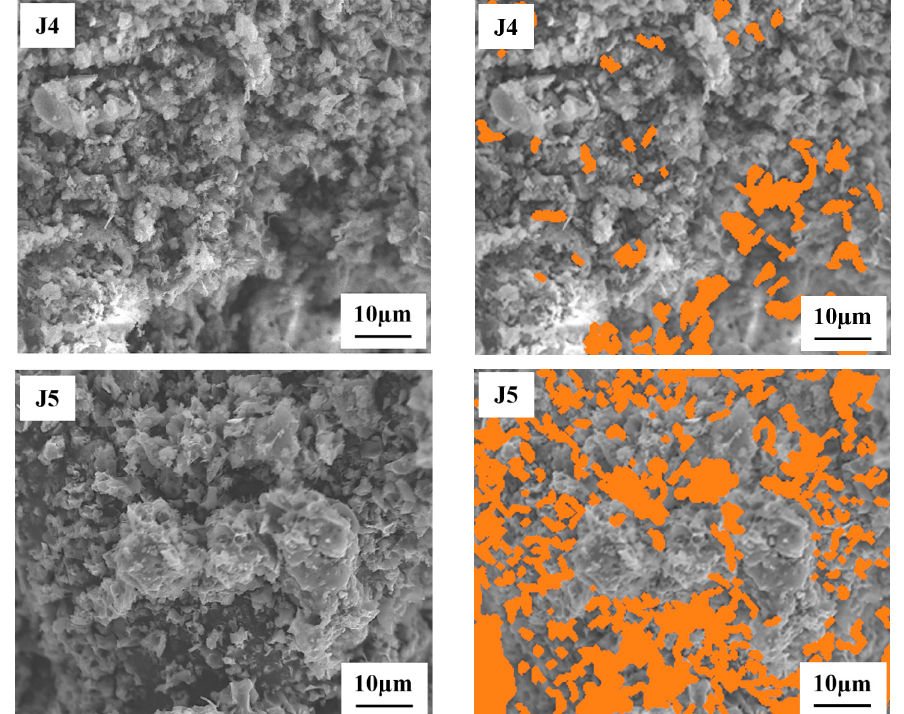
Figure 7. Surface morphology of the various char layer samples.